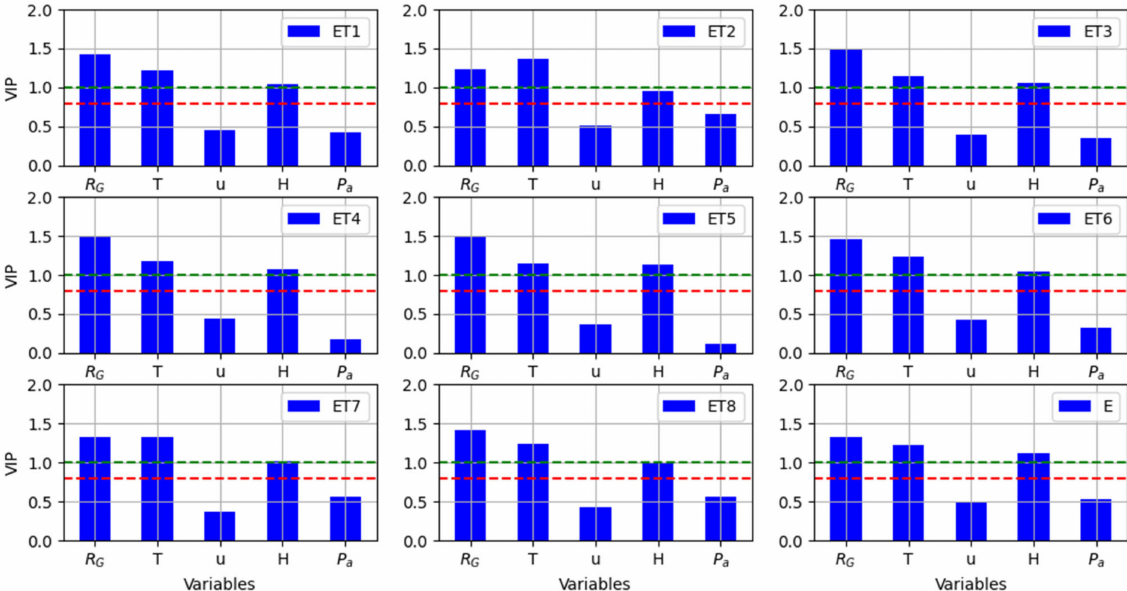
Figure 9. Variable importance in projection (VIP) plots according to partial least squares analysis for lysimeters and evaporimeter. The red and green dashed lines refer respectively to the values of VIP larger than 0.8 and 1. Analysis is conducted based on common data between the explained variables and the evaporation (E) or the lysimeter evapotranspiration